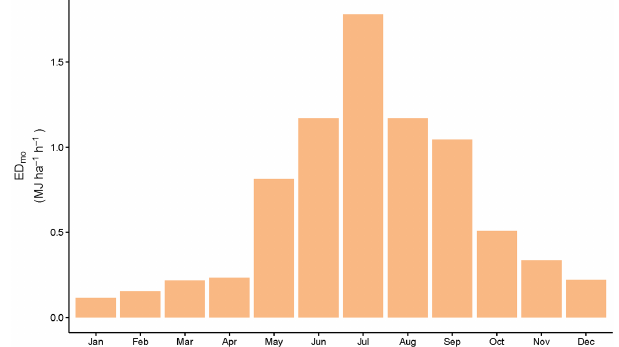
Figure 8. Mean monthly erosivity density (ED mo ) as ratios of R mo (interpolated erosivity maps based on regression–kriging) to P mo (precipitation sums from RhiresM) for